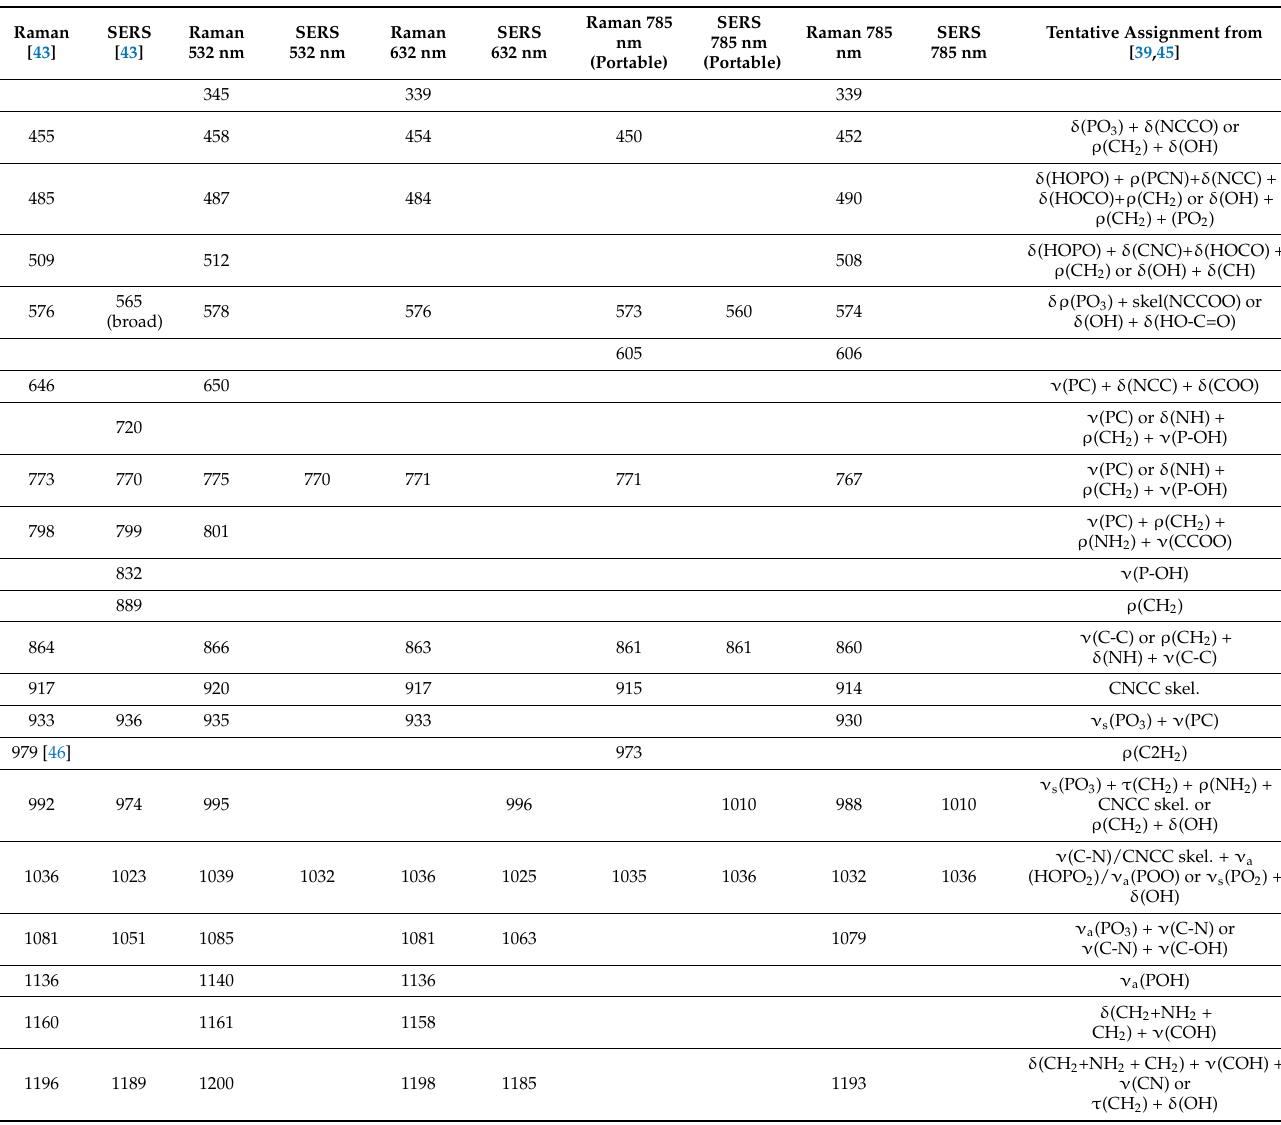
Table 3. Experimental glyphosate peak positions (cm − 1 ) observed in Raman and SERS